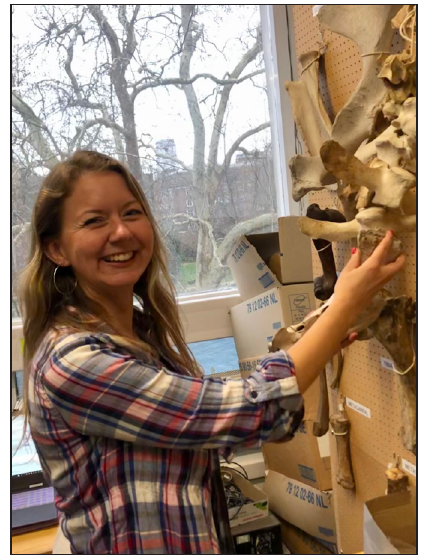
Figure 5: Lucy Sladen in the Zooarchaeology Research Lab in the Institute of